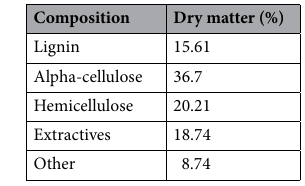
Table 1. Composition of Hom–Mali rice straw used in this study.